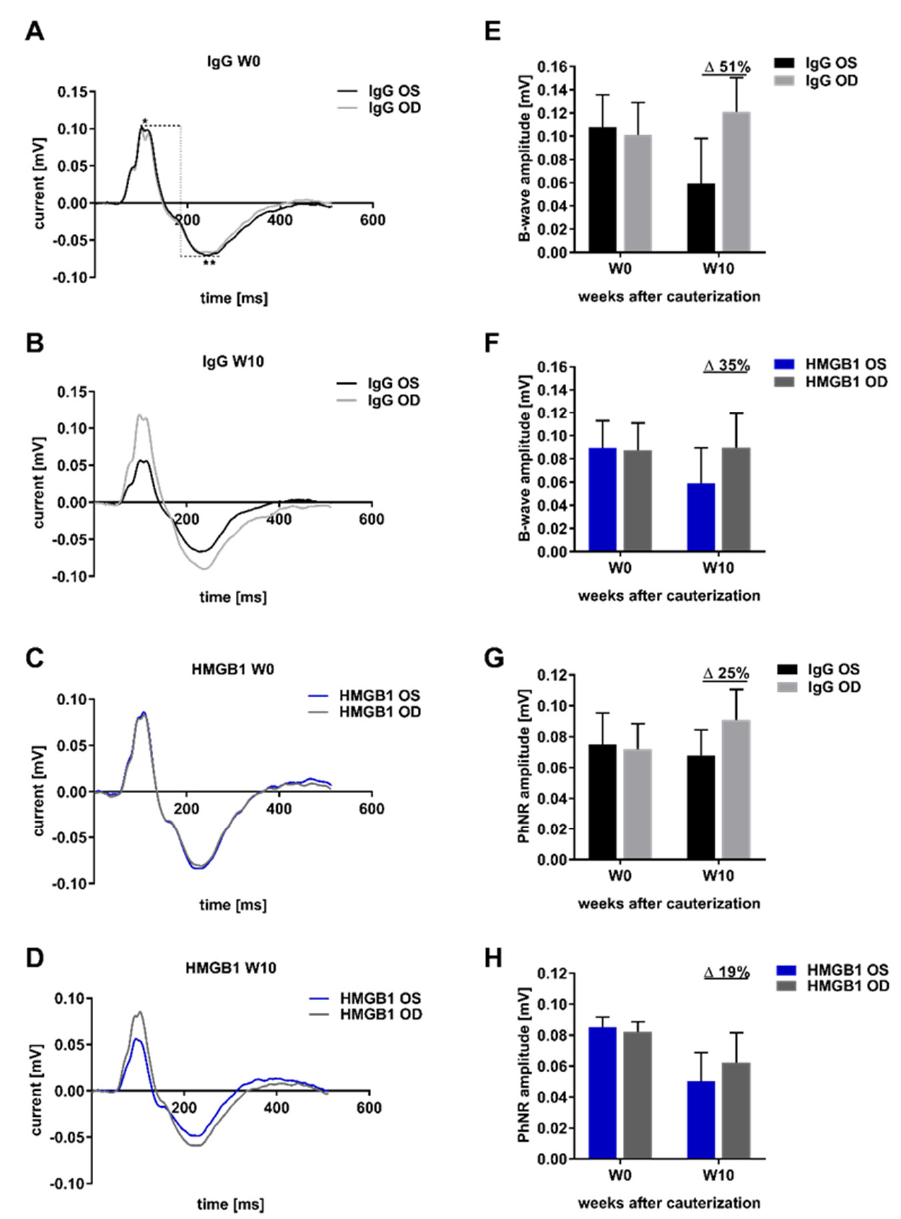
Figure 4. Ganzfeld electroretinogram (ERG) pattern and quantification of B-wave and PhNR ampli- tude at week 0 and week 10. ERG recordings were acquired at different time points. The mean values of the ERG recordings of the individual animals were plotted for the time points week 0 (before EVO) and week 10 after EVO ( A – D ). The flash intensity 1.37 log 10 cd · s · m − 2 was used for the ERG recordings shown. The B-wave amplitude (*) and the amplitude of the photopic negative response (PhNR, **) were used for quantification. Quantification was performed separately for the B-wave amplitude of the IgG ( E ) and the HMGB1 group ( F ) as well as for the PhNR amplitude of the IgG ( G ) and the HMGB1 group ( H ). The millivolt decrease was calculated as a percentage difference ( ∆ = %